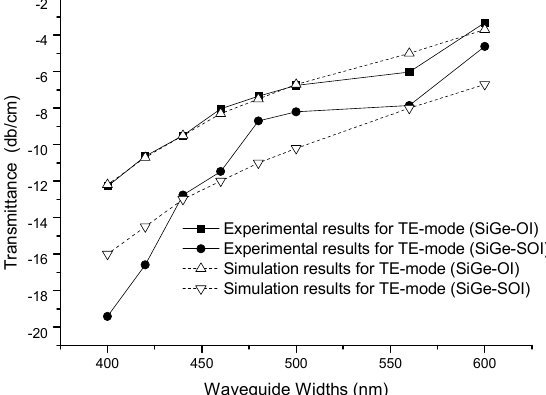
Figure 7. Experimental and simulation results of SiGe-OI and SiGe-SOI waveguide transmittance for TE-mode at the wavelength of 1.55 μ m.